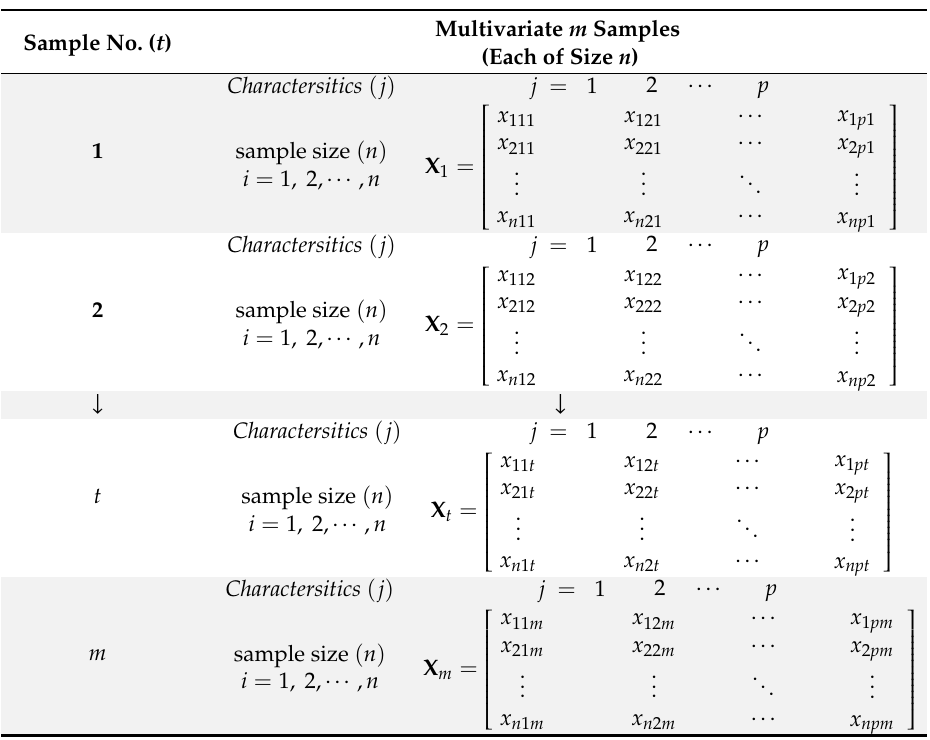
Table A1. Multivariate data